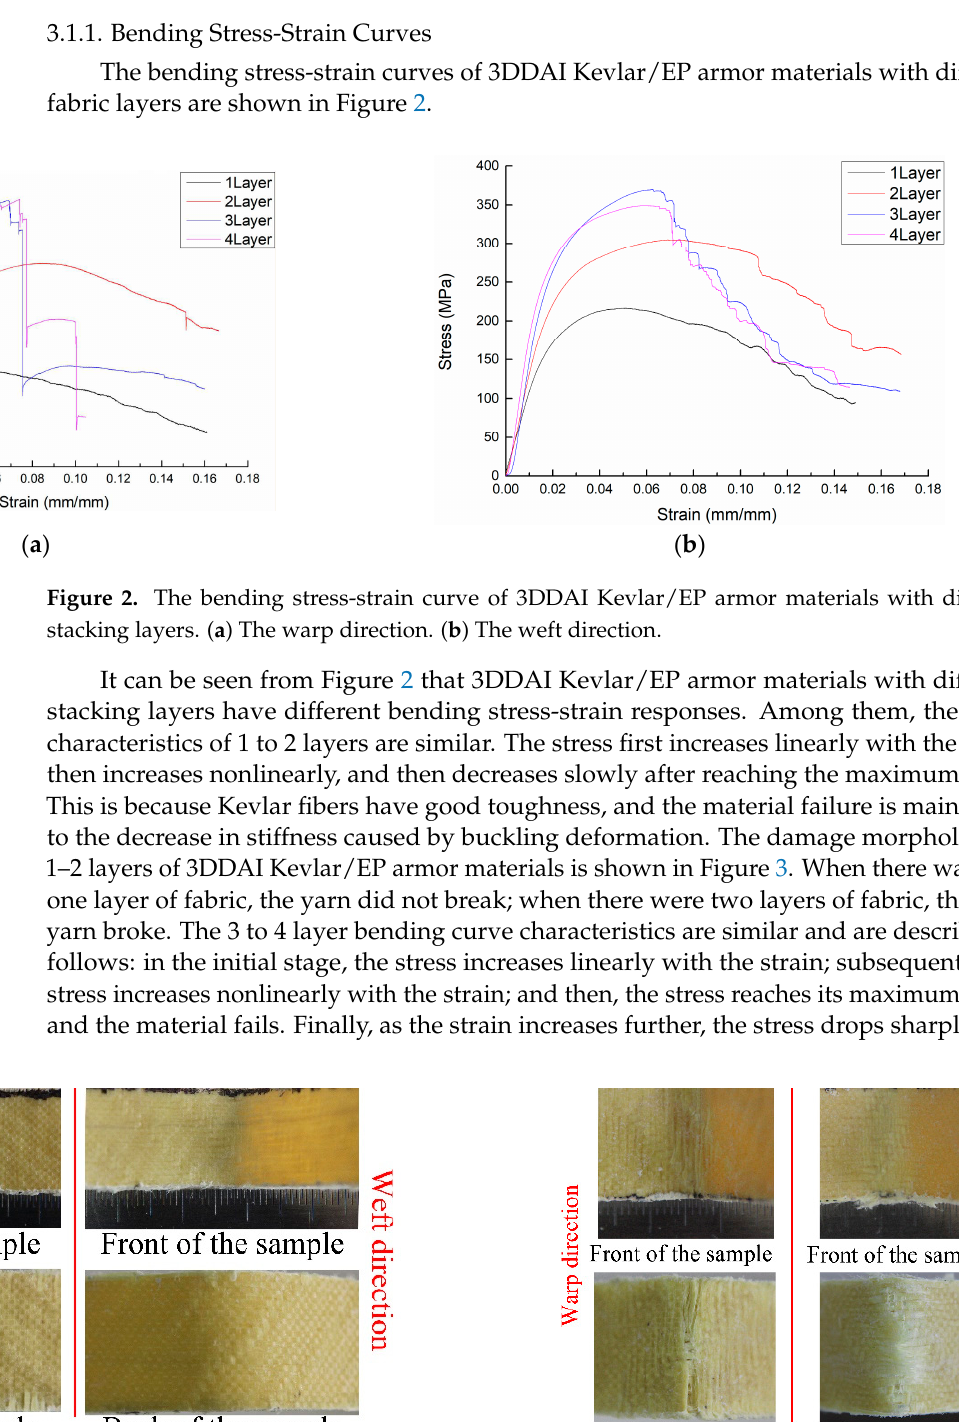
Figure 1. Schematic diagram of 3DDAI fabric.